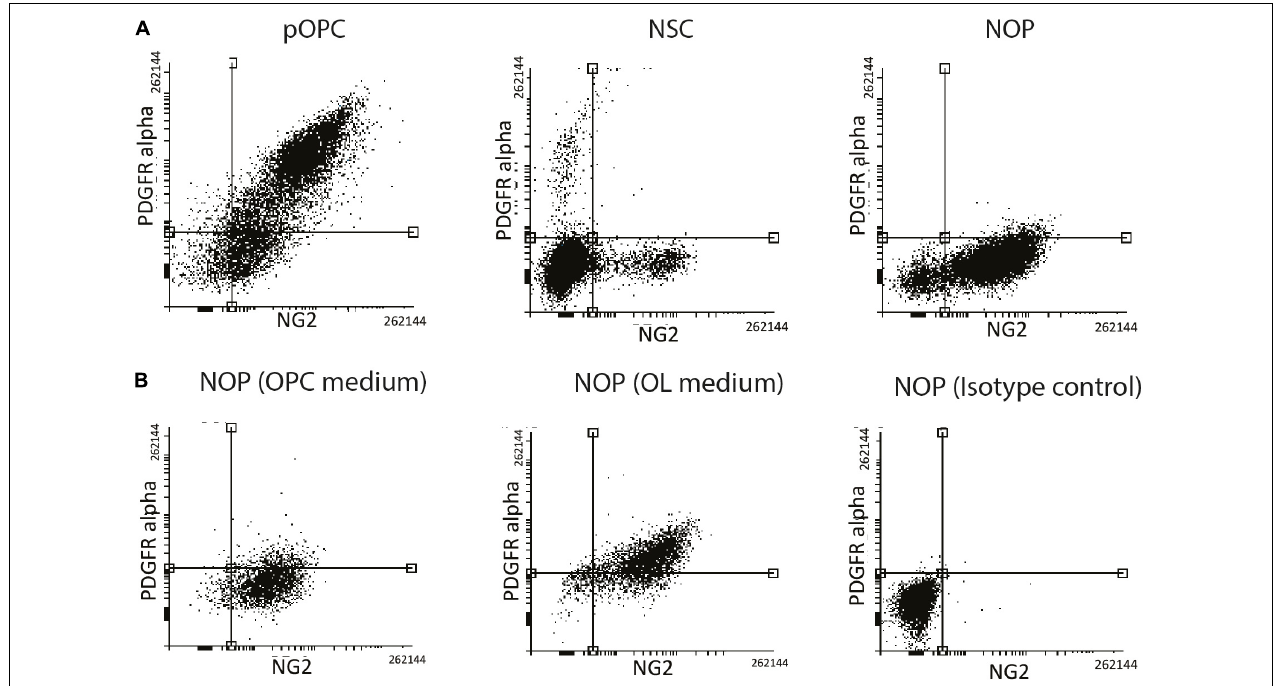
FIGURE 3 | NOP acquire an pOPC-like phenotype after T3 stimulation. (A) Absence of PDGFR α protein distinguishes NOP from pOPC. Expression analysis of NG2 (X-axis) and PDGFR α (Y-axis) from cultures of NSC, NOP and pOPC by FACS. (B) FACS analysis of NG2 (X-axis) and PDGFR α (Y-axis) signals from NOP, and NOP after a 6-day growth period in OL medium containing T3. Left and middle panels display data from NOP and NOP cultures after OL medium (respectively) that were labelled with anti-NG2 and anti-PDGFR α . Right panel displays negative control data from NOP labelled with isotype control antibodies for each marker protein as a negative